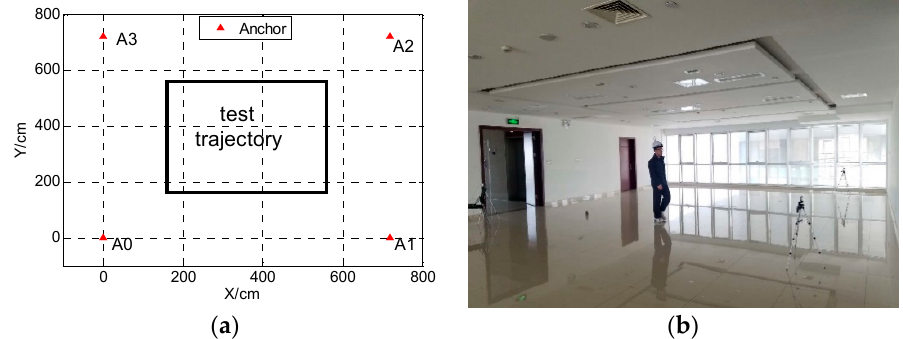
Figure 12. The test trajectory ( a ) and the experimental scene ( b ).